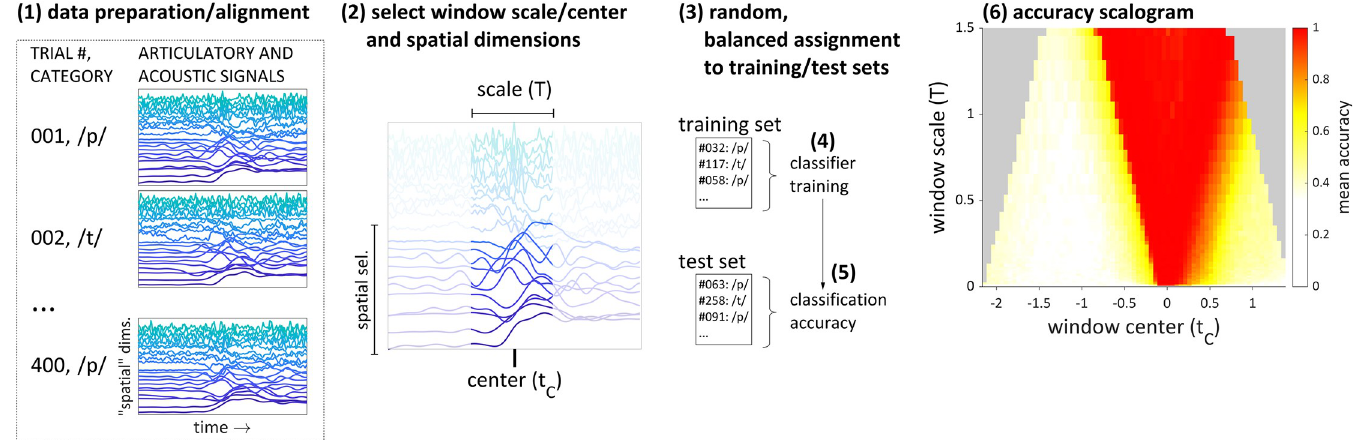
Fig 2. Overview of multi-scale analysis procedure. (1) observations of category-associated multi-dimensional time series are collected and aligned to a common event. (2) a window scale/center and spatial dimensions are selected. (3) observations are randomly assigned to training and test sets. (4) a discriminant classifier or neural network is trained to classify observations. (5) accuracy on the test set is recorded. Steps (3)-(5) are iterated for a range of window centers and scales, allowing for an accuracy scalogram to be constructed (6).